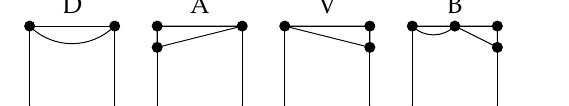
Figure 6. Alphabet letters describing top paths in tiles from S .